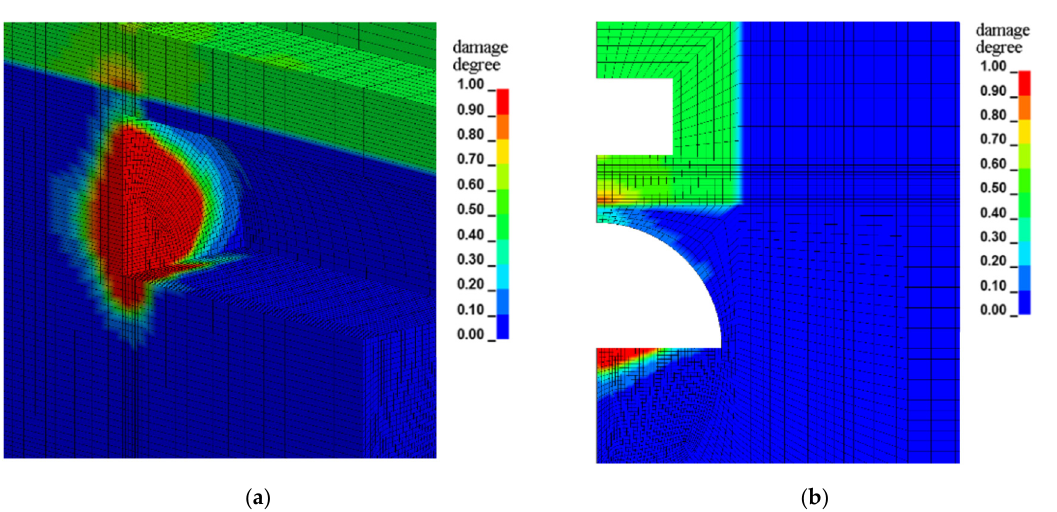
Figure 11. Blasting damage diagram of surrounding rock ( d = 2 m). ( a ) three-dimensional blasting damage diagram. ( b ) cross ‐ section blasting damage diagram.